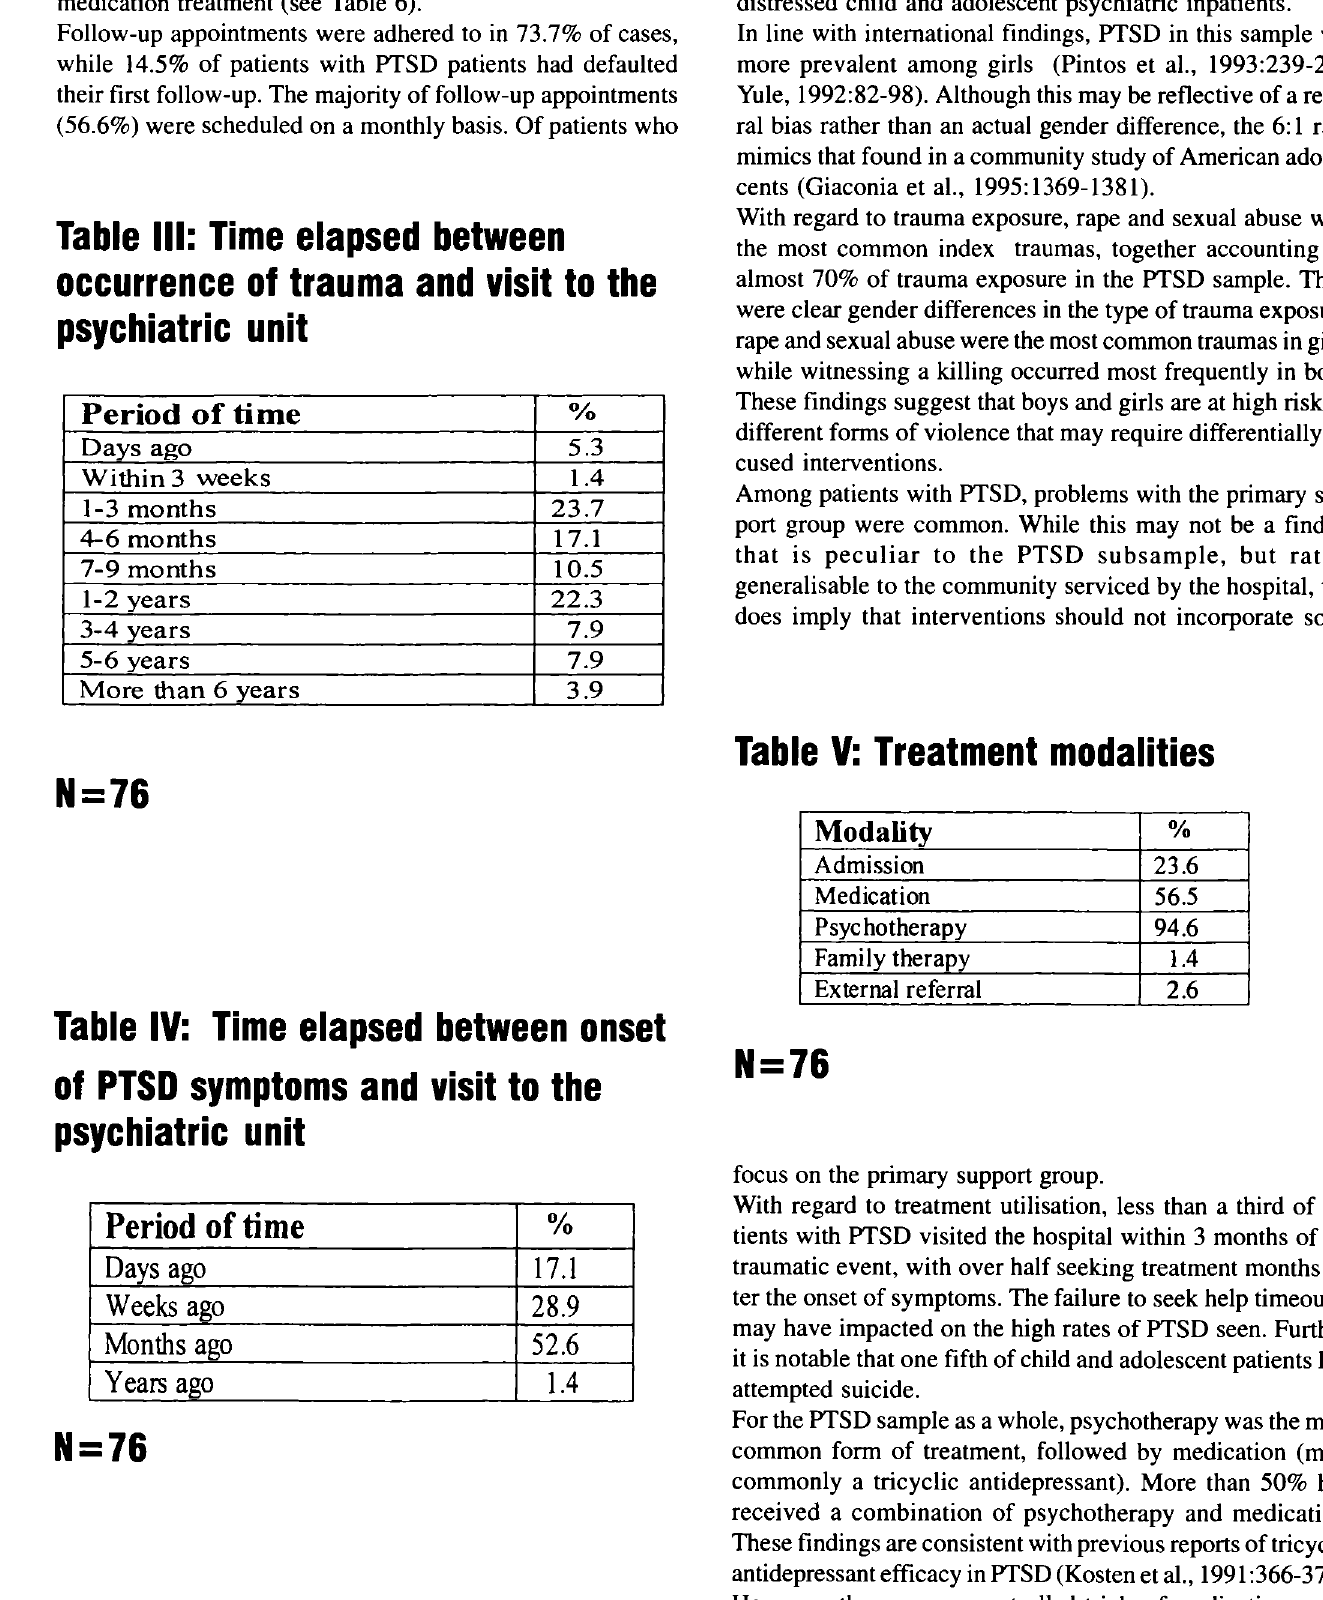
Table IV: Time elapsed between onset of PTSD symptoms and visit to the psychiatric